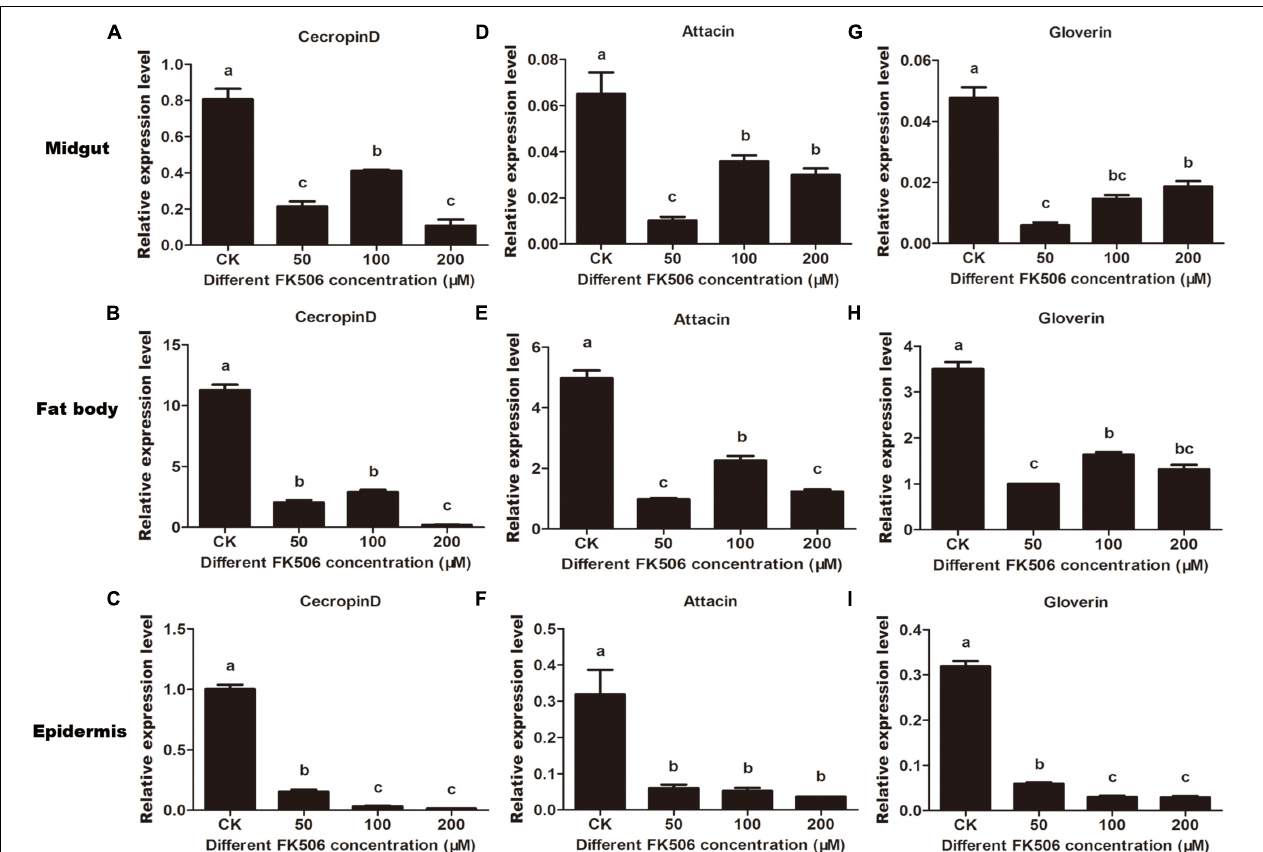
FIGURE 4 | Expression levels of endogenous antimicrobial peptides (cecropin D, attacin, and gloverin) in midgut, fat body and epidermis after feeding FK506 (0, 50, 100, and 200 µ M) were analyzed by quantitative real-time PCR. (A–C) Represent the relative expression levels of cecropin D in the migut, fat body, and epidermis, respectively. (D–F) Represent the relative expression levels of attacin in the migut, fat body and epidermis, respectively. (G–I) Represent the relative expression levels of gloverin in the migut, fat body, and epidermis, respectively. Values shown are means and standard errors. Statistically significant differences for experimental comparisons are indicated by different small letters [analysis of variance (ANOVA) and Tukey’s test, P < 0.05; DPS7.05].